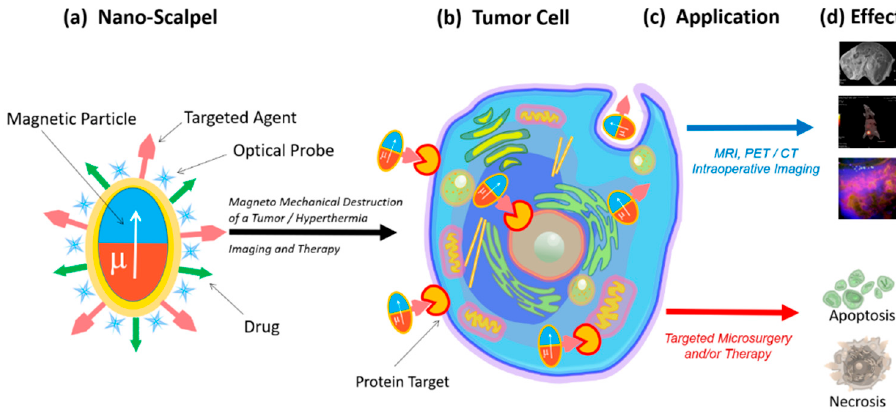
Figure 1. Schematic representation of the novel nanoscalpel device ( a ): binding selectively to tumor cells ( b ) for different applications ( c ) such as accurate diagnostics and targeted therapy ( d ).